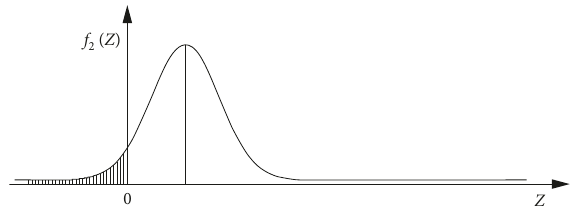
Figure 1: Probability density curve of performance